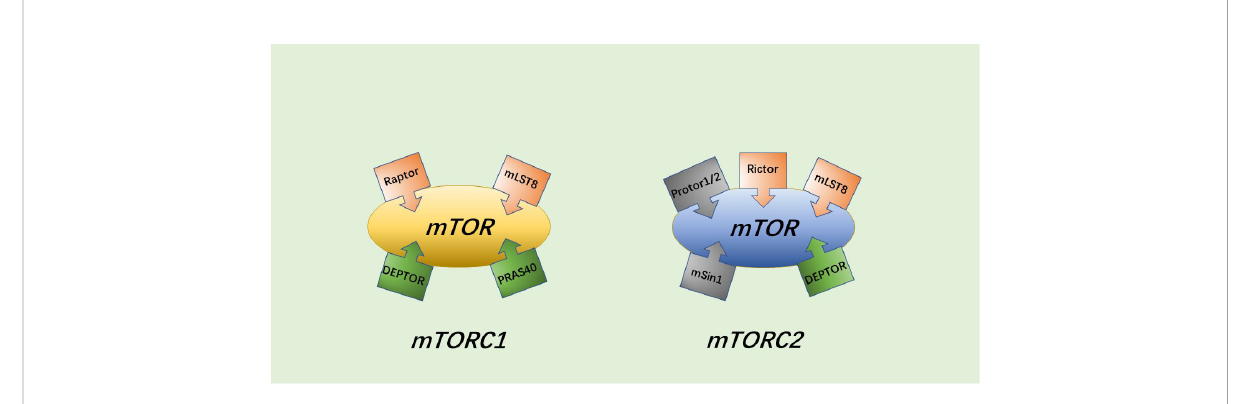
FIGURE 1 The general structure of mTORC1 and mTORC2.